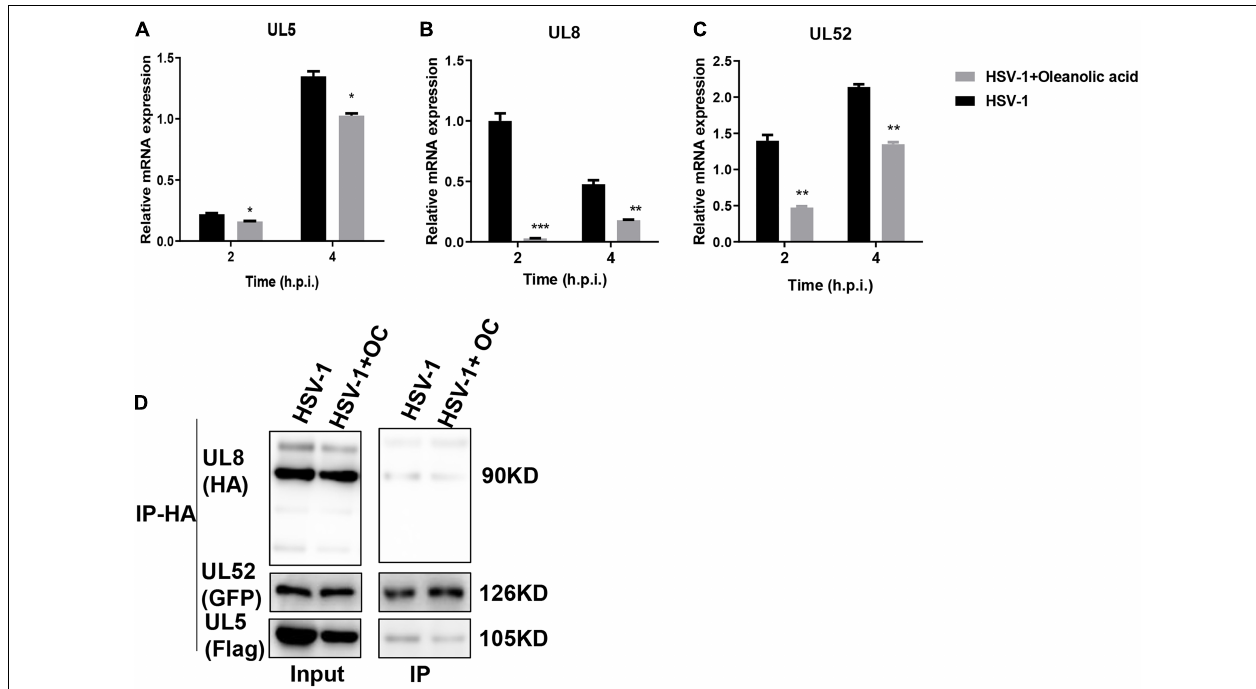
FIGURE 4 | Oleanolic acid inhibits the expression of genes related to the HSV-1 helicase-primase complex. (A–C) HaCaT cells were treated with HSV-1 (MOI = 5) and Oleanolic acid (20 µ M) for 2 and 4 h. Total RNA was extracted and the mRNA expression levels of gene UL5 , UL8, and UL52 were detected by RT-qPCR. Data are mean ± SD ( n = 3). * p < 0.5, ** p < 0.01, *** p < 0.001. (D) The cells were transfected with overexpression plasmid Flag- UL5 , HA -UL8, and EGFP- UL52 for 24 h and were infected with HSV-1 (MOI = 5) in the presence or absence of Oleanolic acid (20 µ M) for 4 h. Cell lysates were collected and subjected to immunoprecipitation with anti-HA antibody and protein A/G-agarose. Immunoprecipitates were detected by western blot assay with anti-GFP, anti-HA and anti-Flag